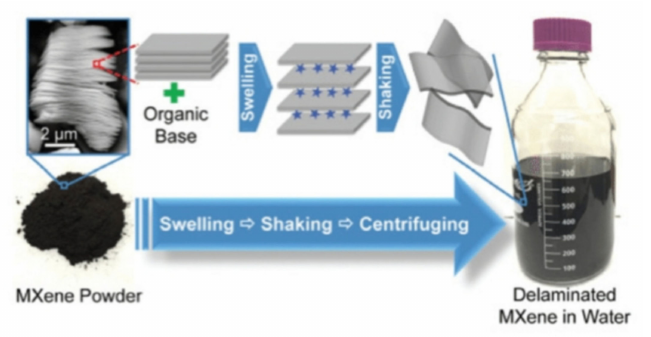
Figure 5. Schematic representation of delamination process of MXene. Reprinted with permission from ref. [65] (J. Zhu et al., 2017); Copyright 2017 Elsevier